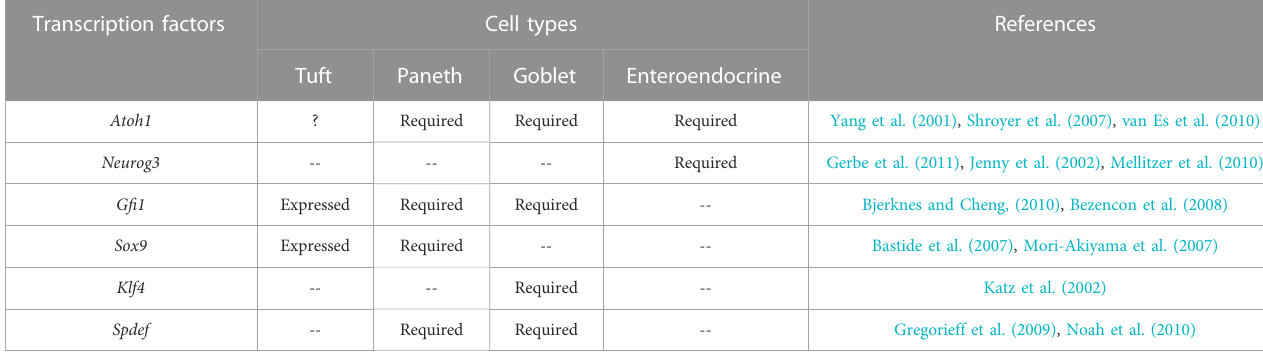
TABLE 2 Summary of the transcription factors involved in TCs and other secretory IECs. Transcription